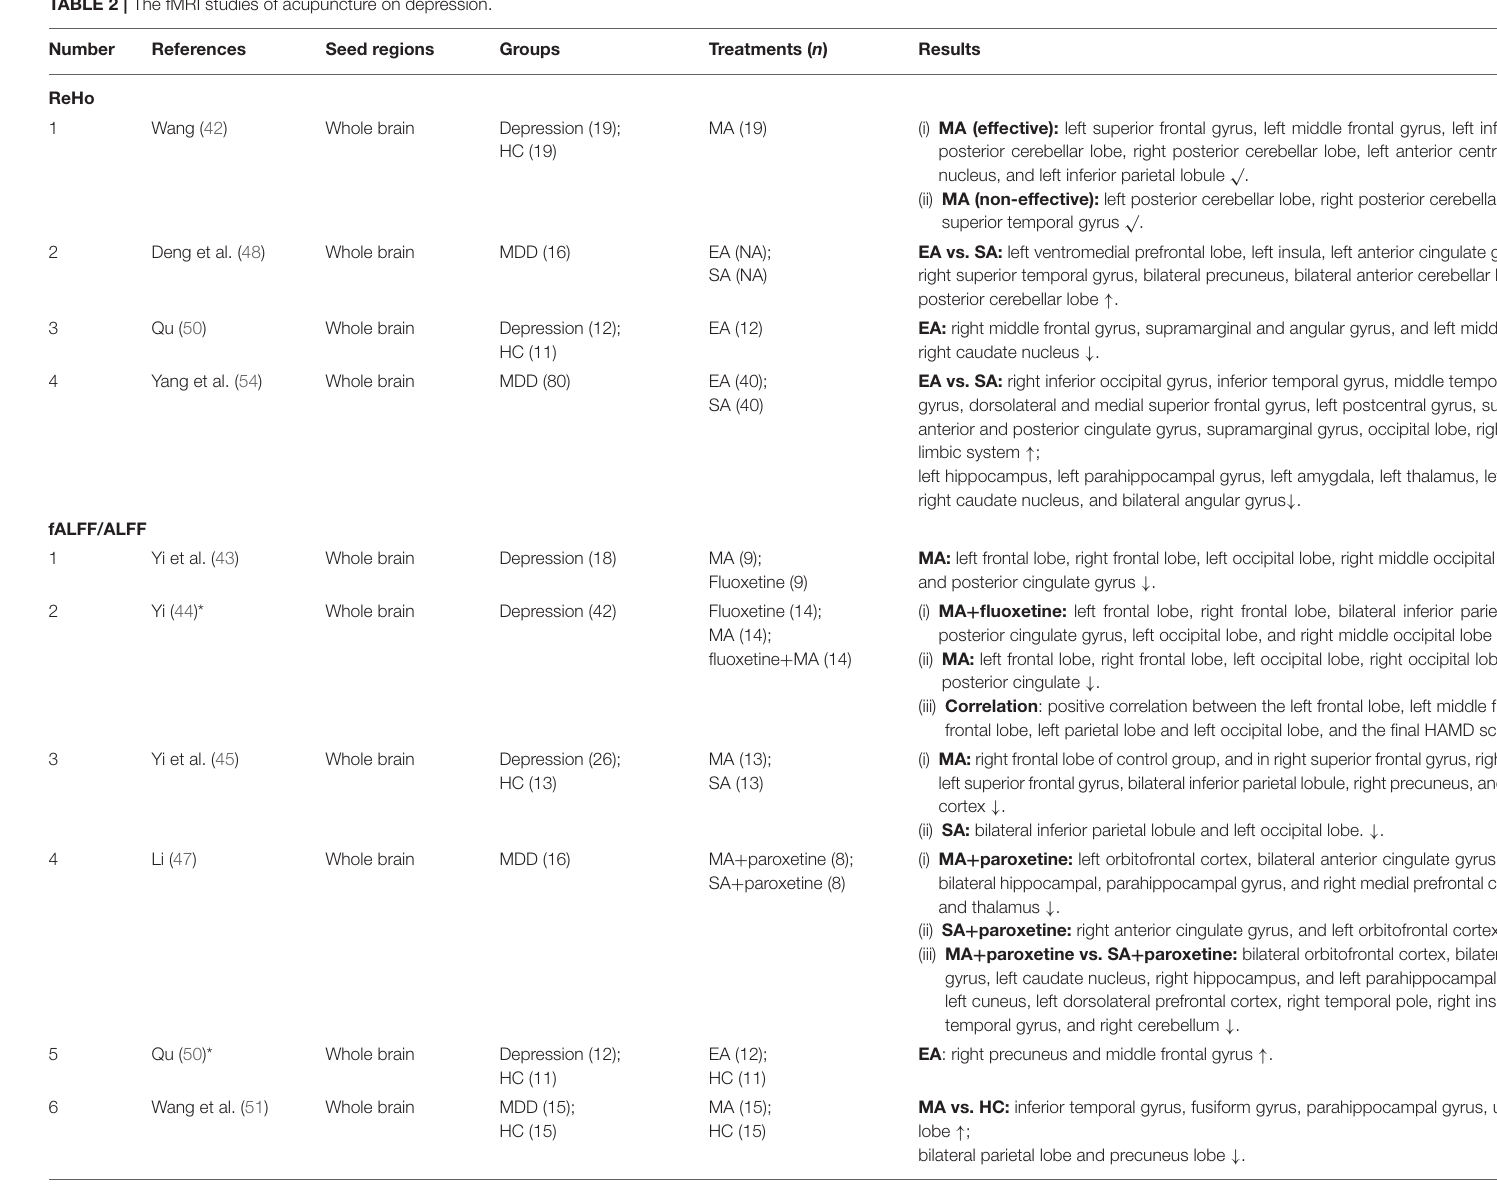
TABLE 2 | The fMRI studies of acupuncture on depression.